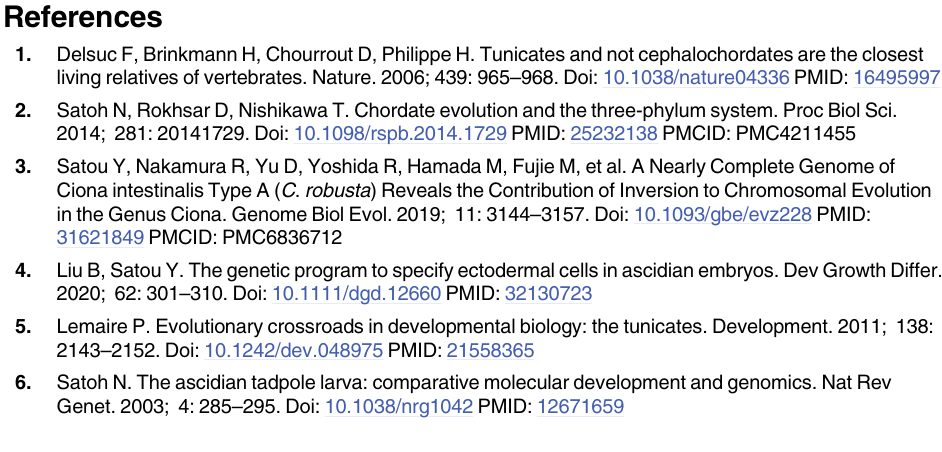
S1 Table. Raw reads and calculated RPKM values for RNA-seq data. S2 Table. Ciona TSGs with GO terms. S3 Table. Primers used in this